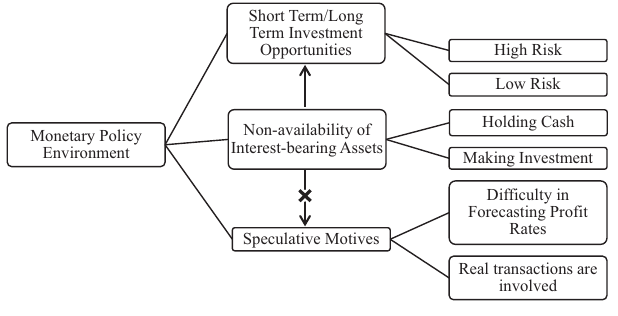
Figure 2. Adaptation of monetary policy environment as envisaged by Chapra (1983,